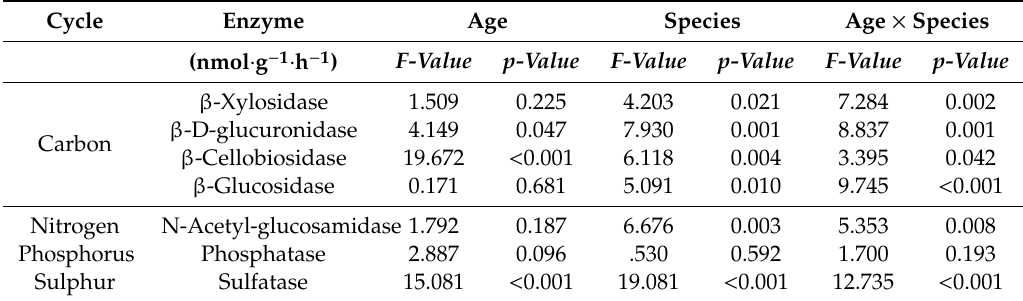
Table 3. Two-way ANOVA analysis showing the di ff erences in soil enzyme activity between plantations.